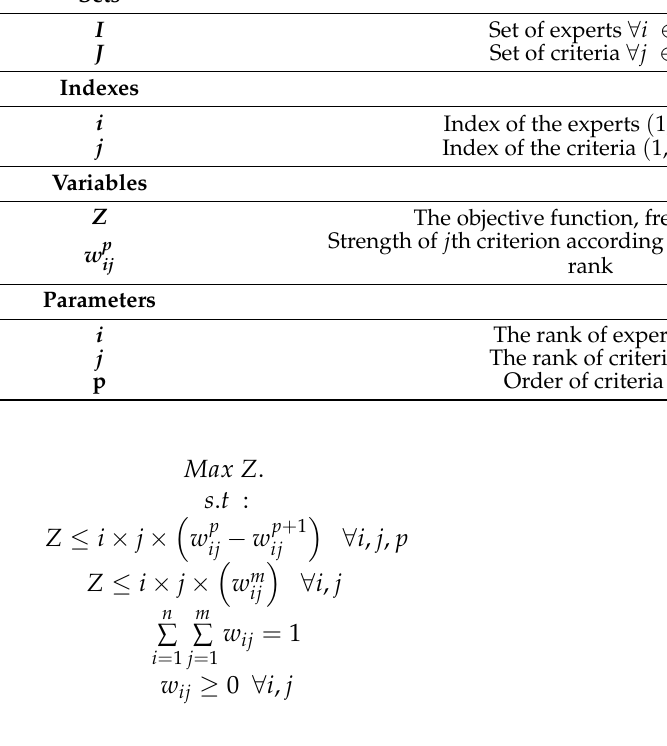
Table 5. Sets, indexes, parameters, and variables of the OPA technique.